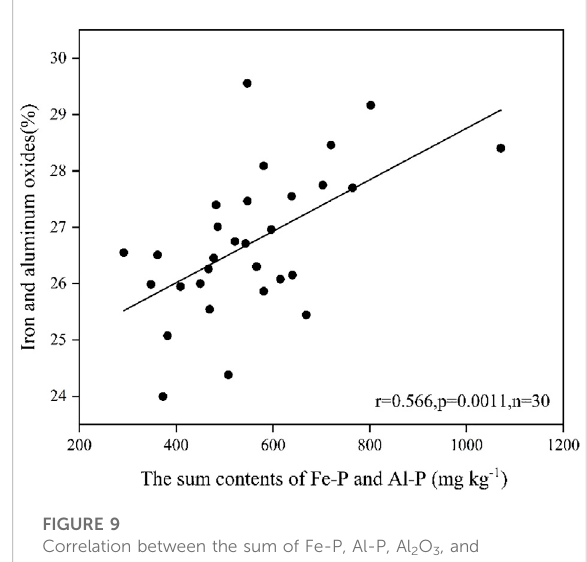
FIGURE 9 Correlation between the sum of Fe-P, Al-P, Al 2 O 3 , and Fe 2 O 3 ratios in soils and